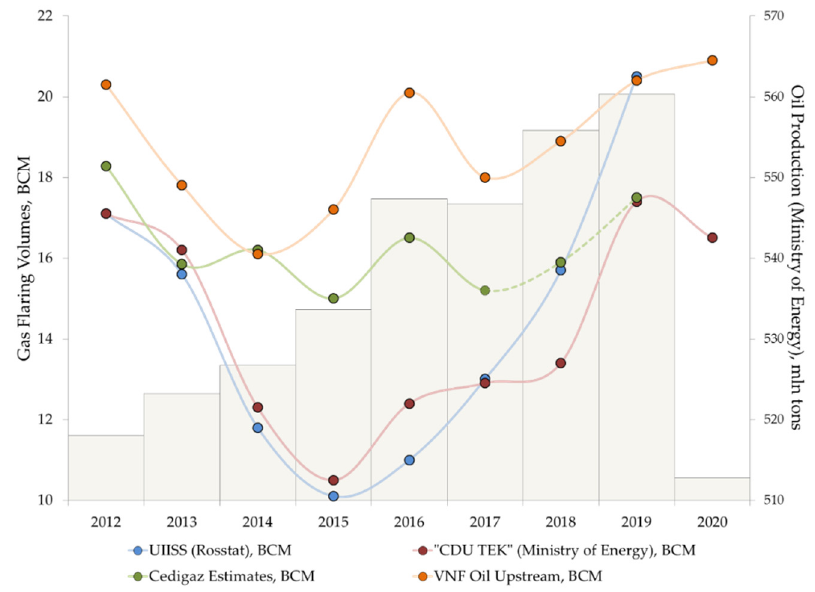
Figure 7. Reported and estimated annual APG (associated petroleum gas) flaring volumes (in BCM) in Russia, 2012–2020, according to official sources (Ministry of Energy, Rosstat), expert data (Cedigaz), and VIIRS Nightfire estimates. Histogram presents annual oil production levels in Russia published by the Ministry of Energy [49]. For Cedigaz, the dotted line represents estimates from 2018–2019 not applied in VIIRS Nightfire calibration. Exact numerical data are presented in Table 1.